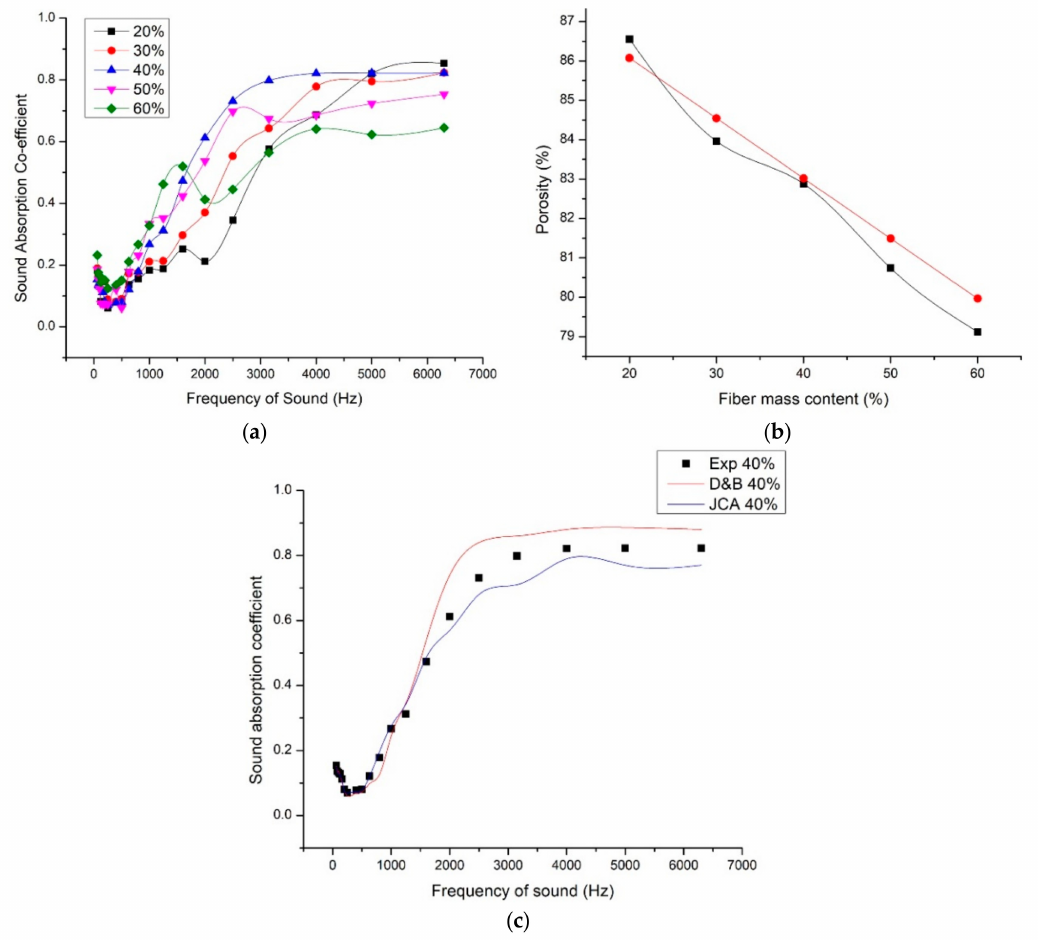
Figure 5. ( a ) Variation of sound absorption coe ffi cient with respect to fiber mass content. ( b ) Change in porosity with respect to fiber mass content [black—measured, red—calculated]. ( c ) Comparison of experimental SAC values with the estimated SAC values using Delany and Bezley model (D&B) and